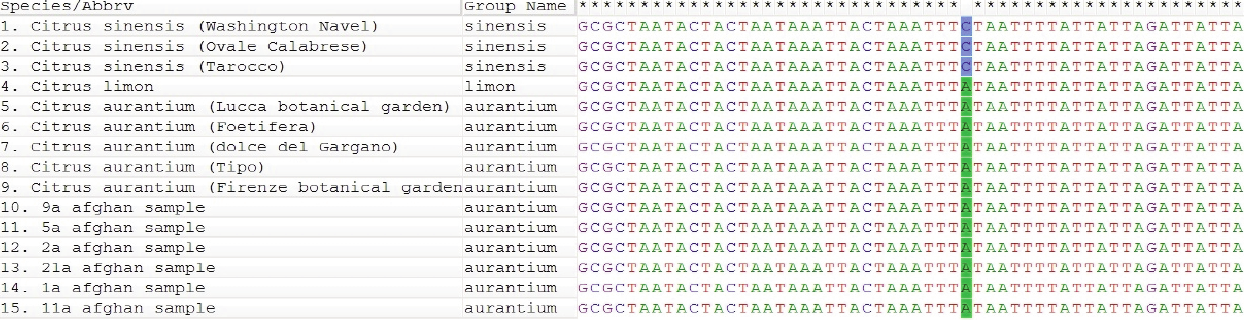
Fig. 2 - Two haplotypes of C. aurantium and C. sinensis originated by a single nucleotide polymorphism getting from the sequencing of psbA‐trnH intergenic spacer ( psbA‐trnH ).